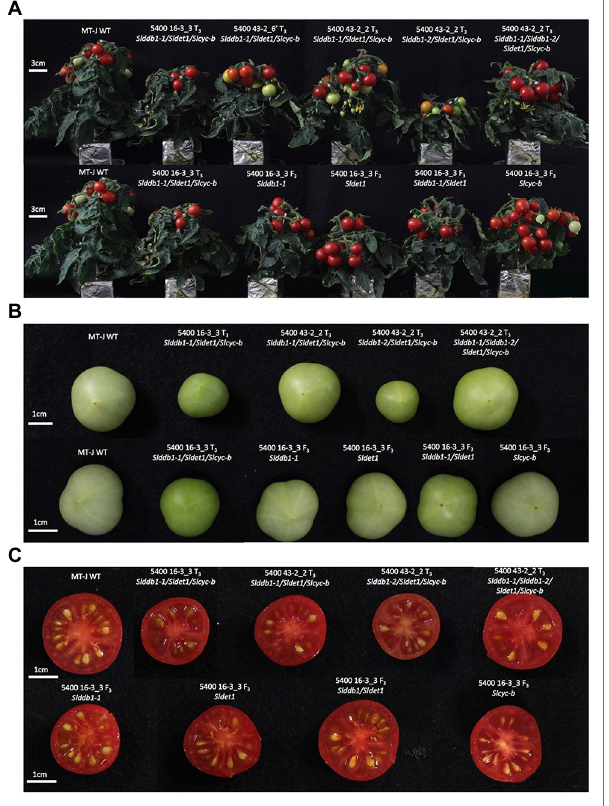
FIGURE 2 | Plant and fruit phenotypes of the segregating generation. (A) Six-week-old plants in the T 3 generation (upper) and BC 1 F 3 generation (lower). (B) Fruit color at the green mature stage (28 days post-anthesis) in the T 3 generation (upper) and BC 1 F 3 generation (lower). (C) Fruit color at the red ripe stage (12 days post-break) in the T 3 generation (upper) and BC 1 F 3 generation (lower). MT-J, Micro-Tom Japan; WT, wild type. T, transformant generation; F 3 , third filial